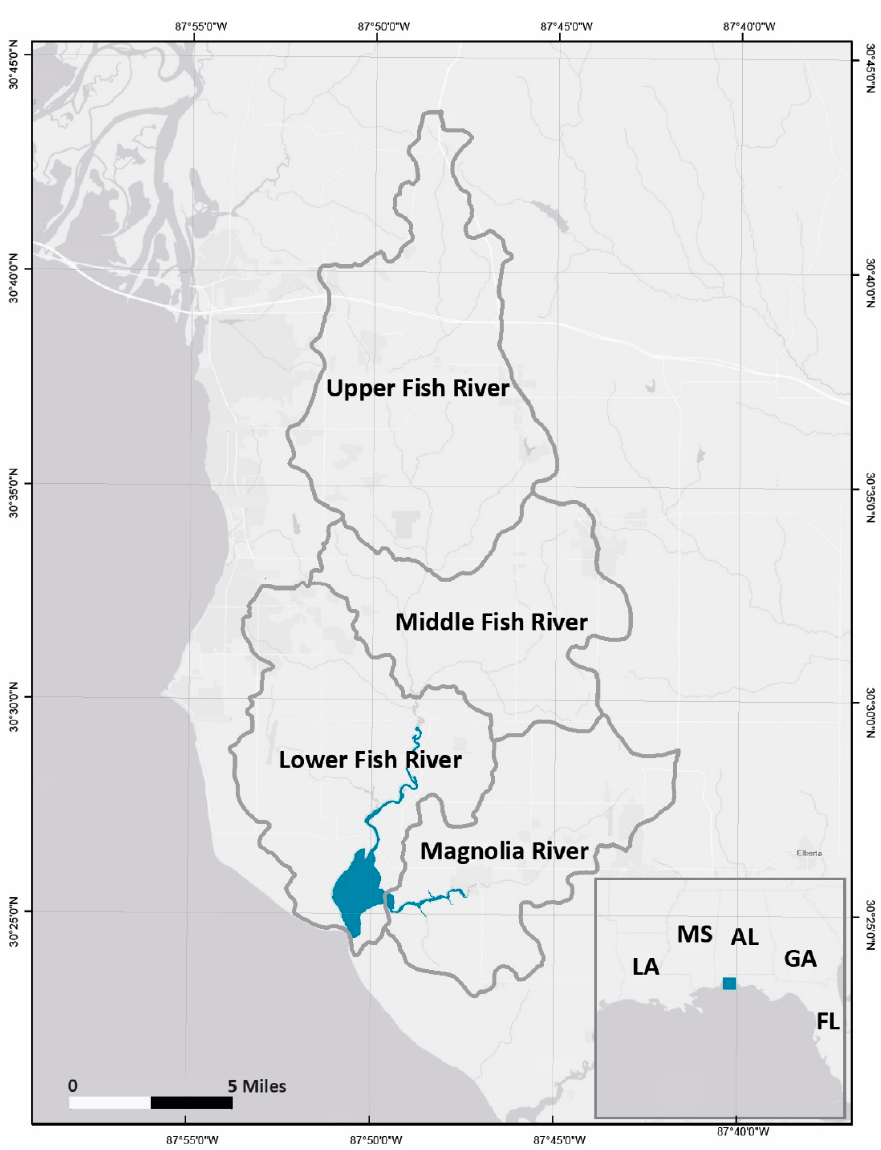
Figure 1. The Weeks Bay watershed located on the eastern shore of Mobile Bay in Alabama, United States along the northern Gulf of Mexico, with the four sub-basins labeled.